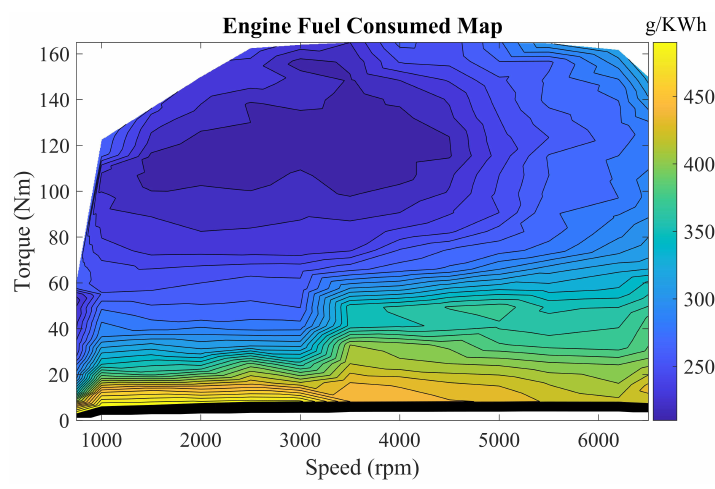
Figure 2. The fuel consumption map of the